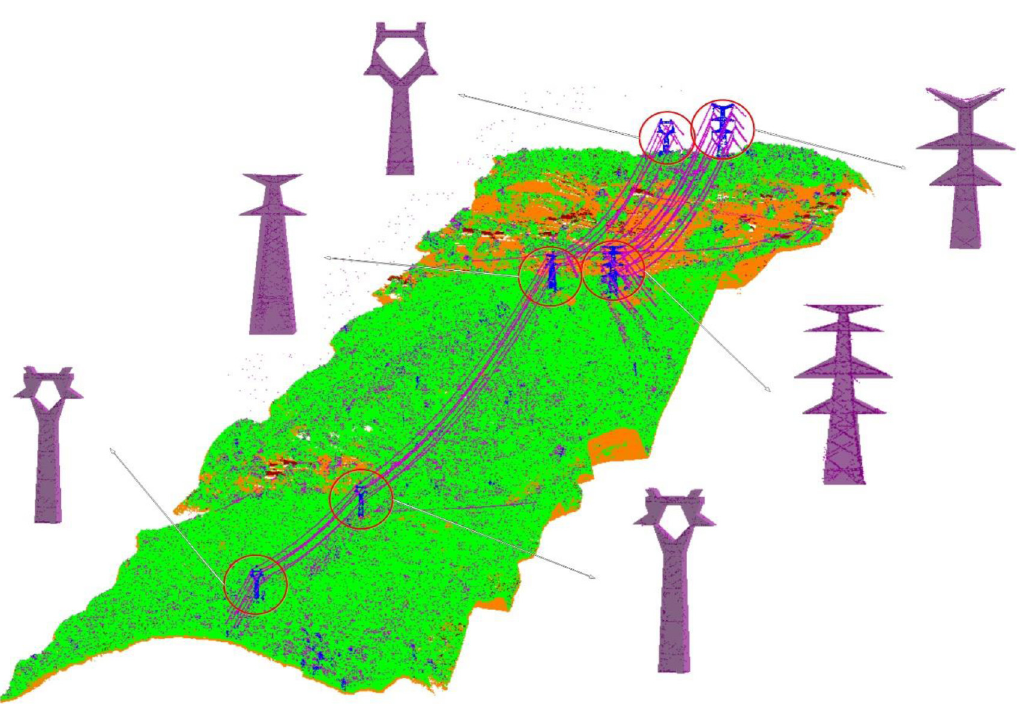
Figure 9. Reconstruction results of Region 2.